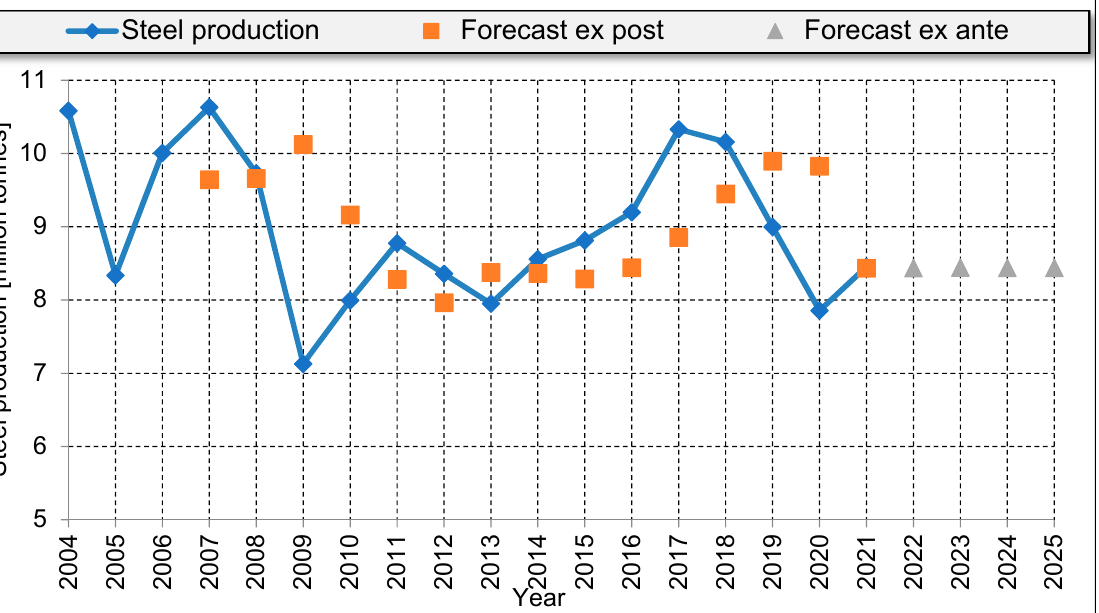
Figure 15. Forecasts of steel production in Poland in the period: 2022–2025.